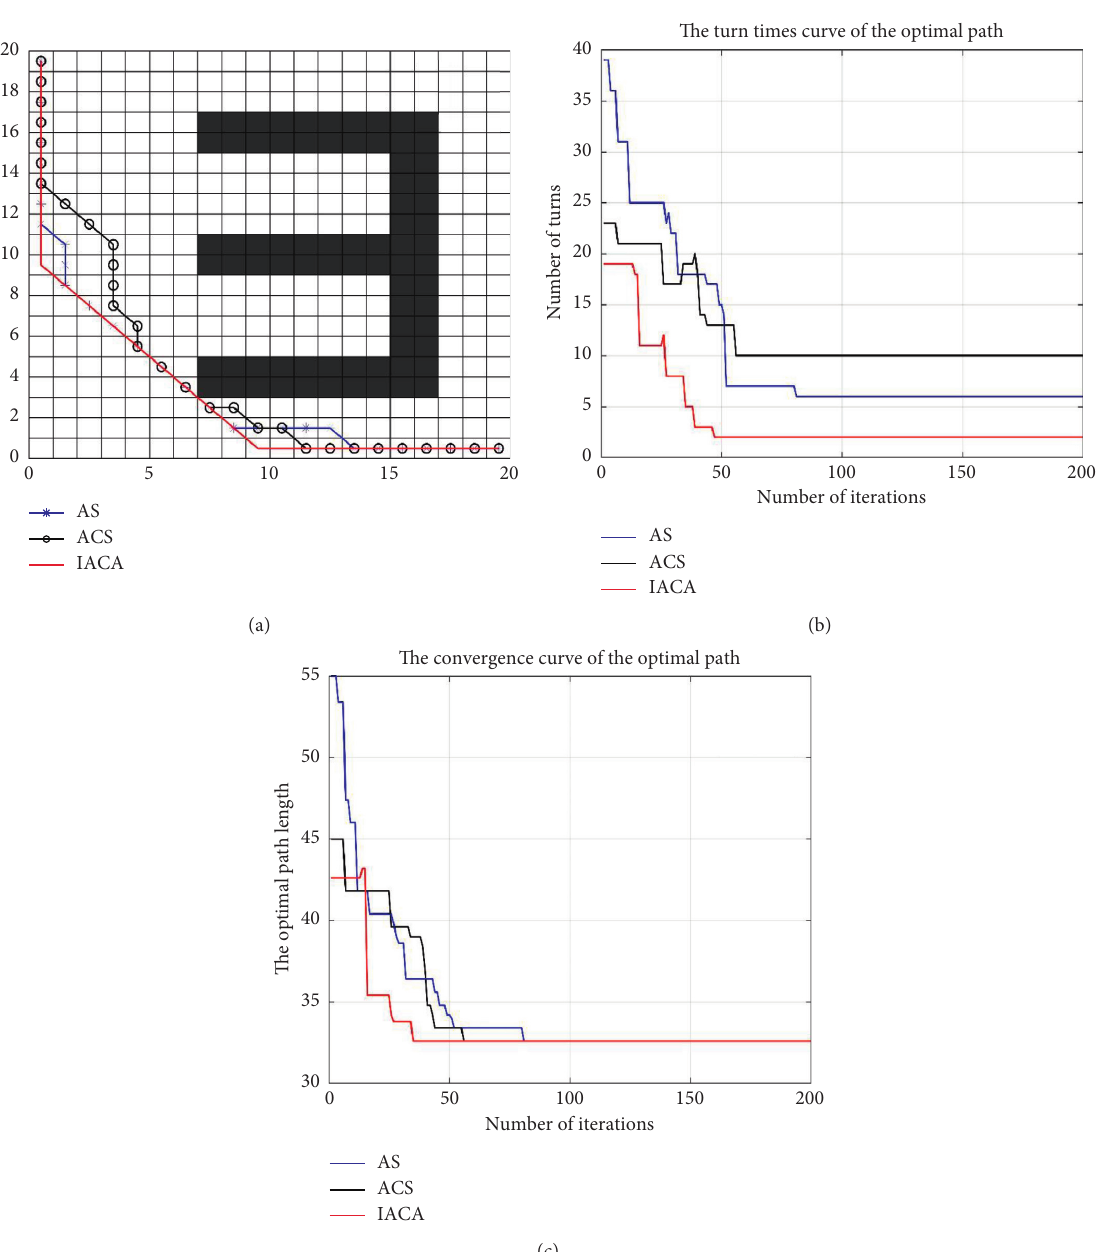
Figure 4: Results of path planning about three algorithms (20 × 20). (a) Path planning in three algorithms (20 × 20). (b) The turns times curve about three algorithms (20 × 20). (c) The convergence curve about three algorithms (20 ×